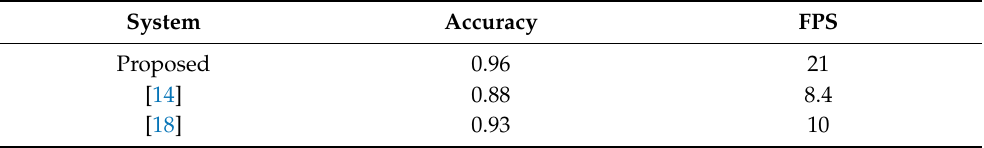
Table 7. Drowsiness detection accuracy of the proposed system using dataset UTA-RLDD